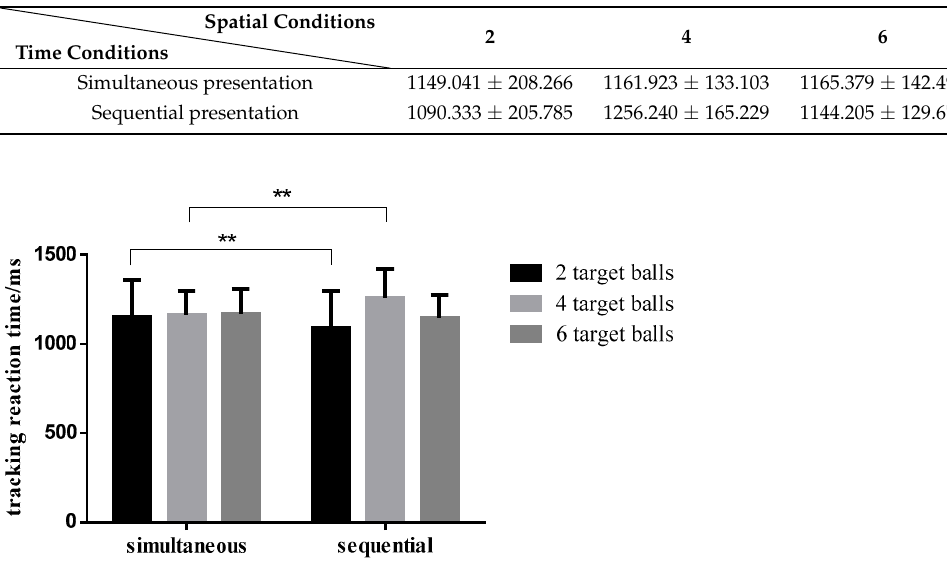
Figure 8. Comparison of the accuracy rate of different numbers of target balls in simultaneous and sequential conditions. Note: ** indicates the significance level is p < 0.01.